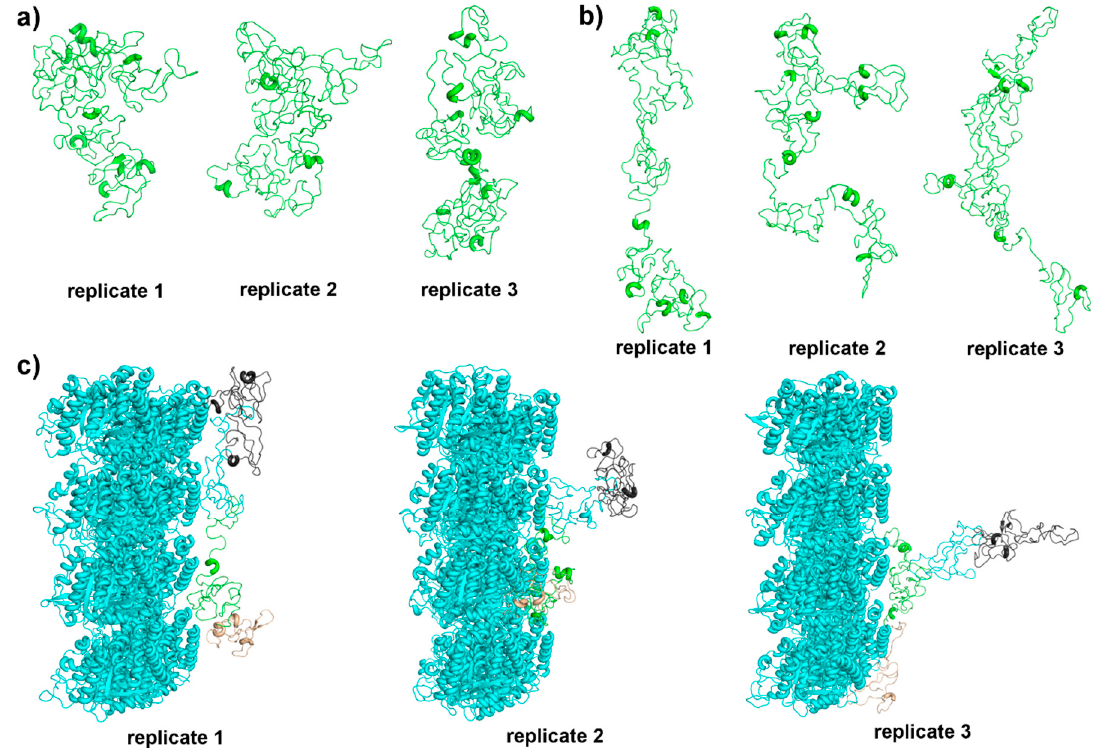
Figure 7. ( a ) Middle structures of tau in fluid, ( b ) middle structures of tau when associated with microtubules, with N-termini oriented to the top, and ( c ) tau::microtubule middle structures, with a color scheme following Figure 2: grey for N-terminal, cyan for proline-rich domain, green representing the MTBR, and beige for C-terminal. ( c ) Microtubule wall is represented in cyan cartoon and ( a,b ) tau is represented in green